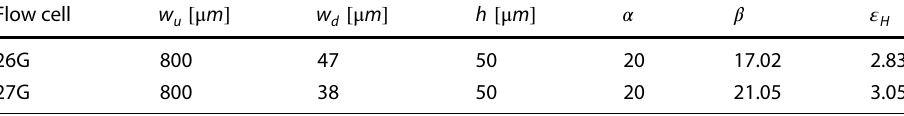
𝛼 and 𝛽 denote the upstream aspect ratio and contraction ratio, respectively. 𝜀 H = ln 𝛽 is the Hencky